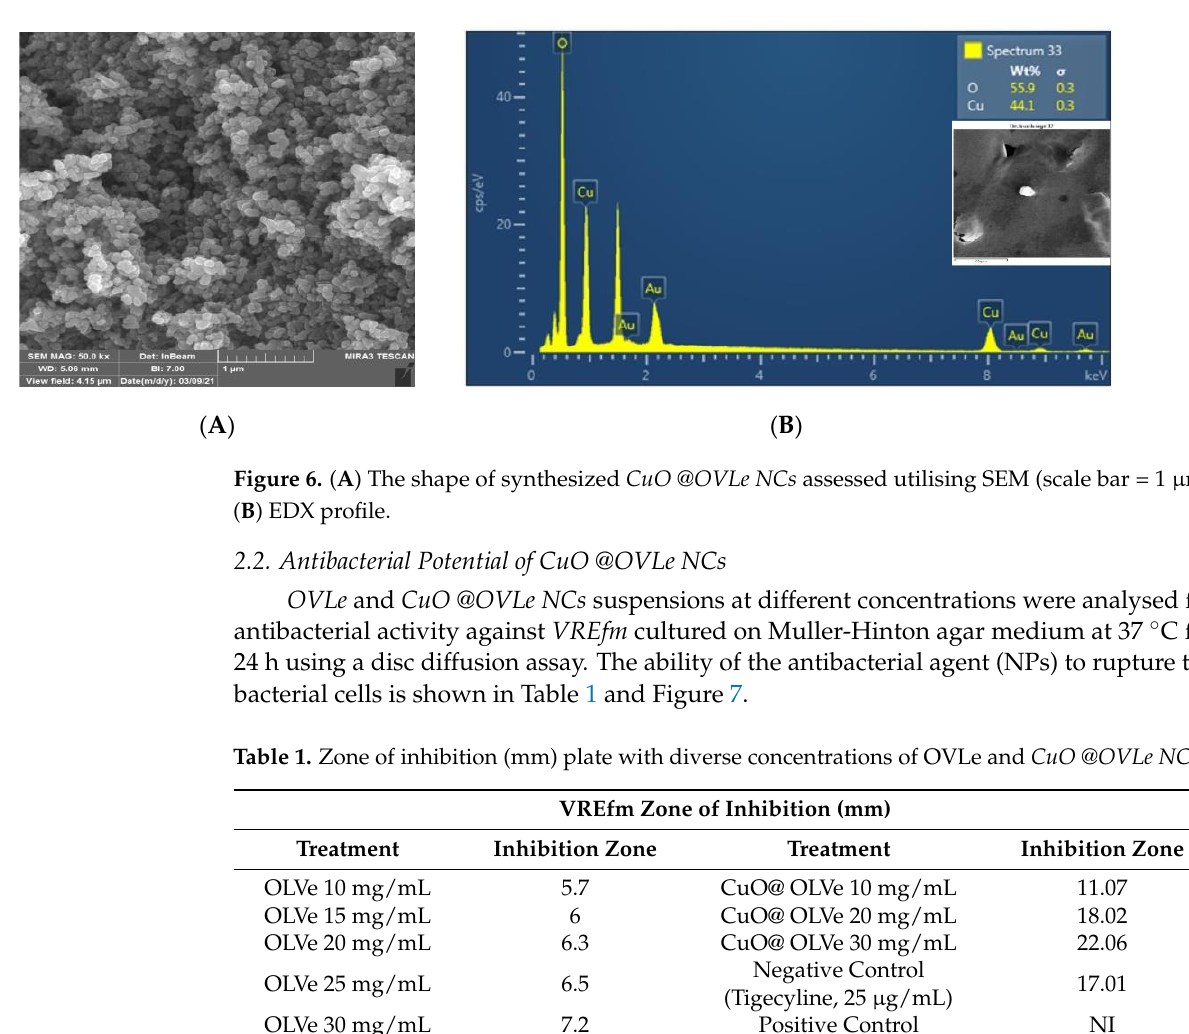
Figure 5. ( A ) Average particle size of prepared CuO @OVLe NCs evaluated utilising TEM (scale bar = 50 nm). ( B ) The size distribution of prepared CuO @OVLe NCs data is shown as the mean ± SD ( n = 3).